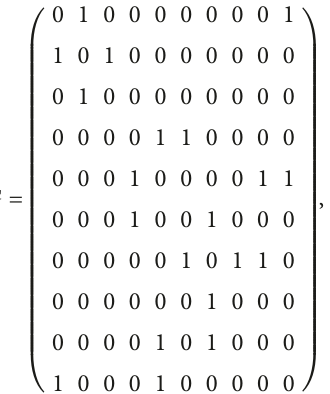
( t ) , x ( t ) , and s ( t ) i 1 i 2